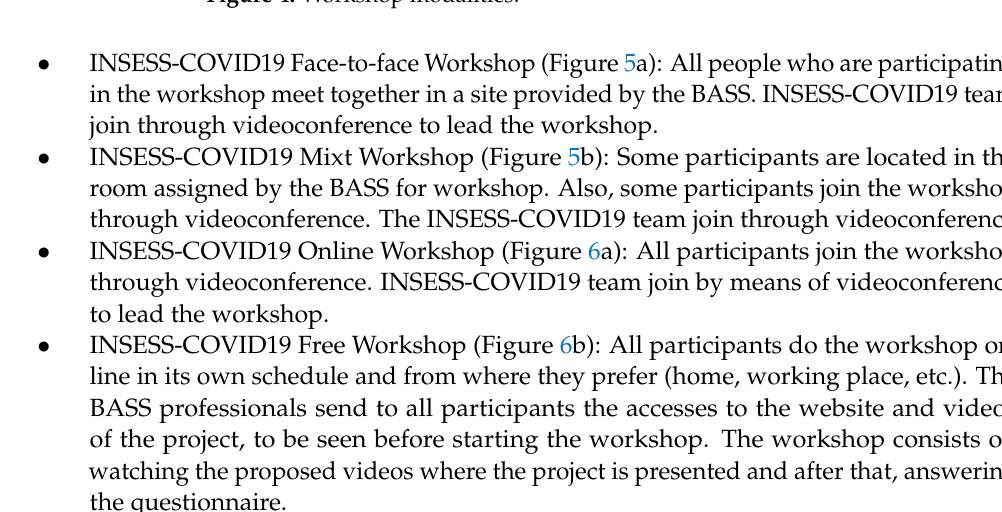
Figure 4. Workshop